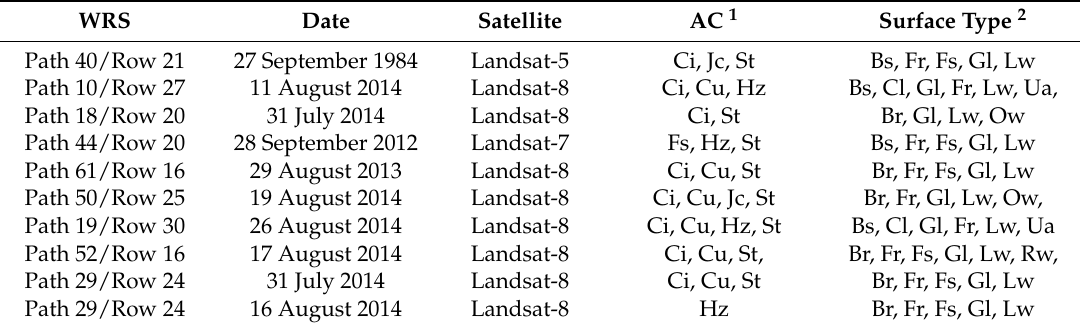
Table 1. The atmospheric conditions (AC) and surface types in ten selected Landsat scenes (listed in the same order as in Table